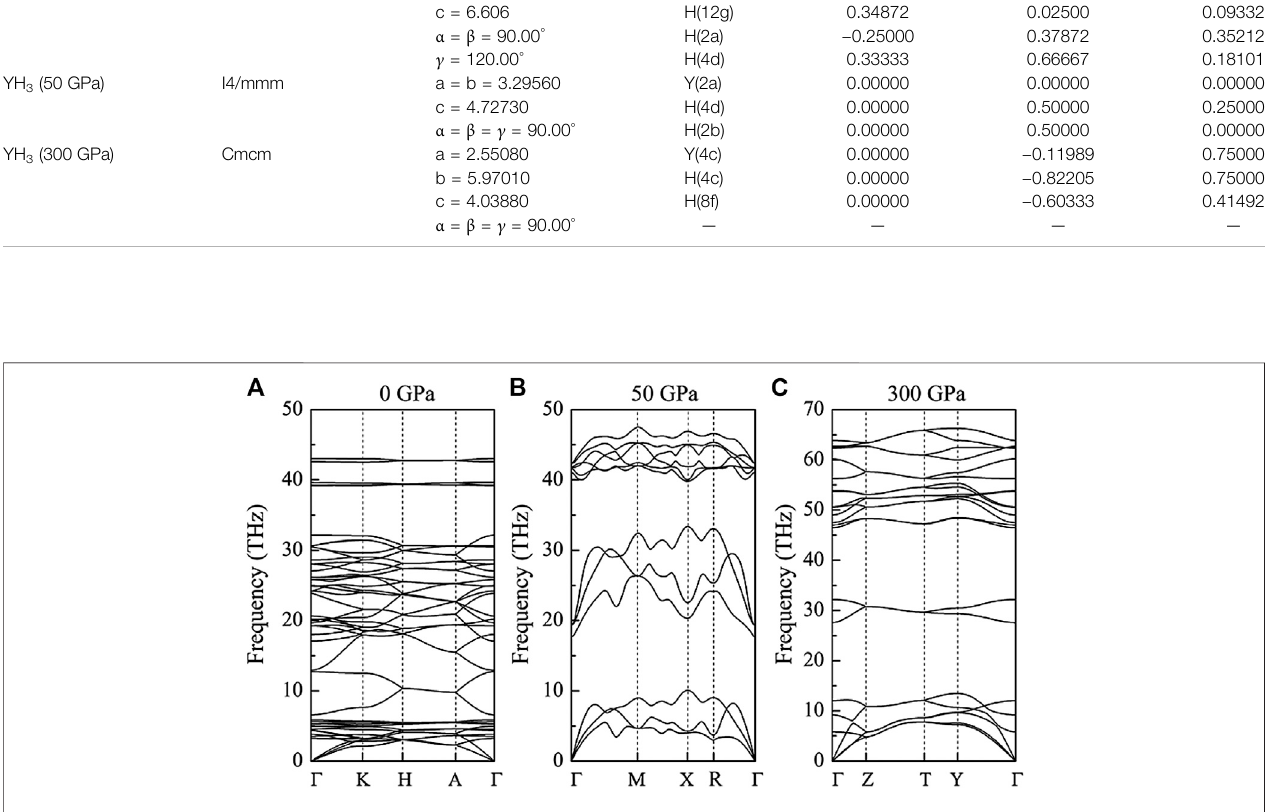
FIGURE 2 | The phonon dispersion for YH 3 under different pressures.